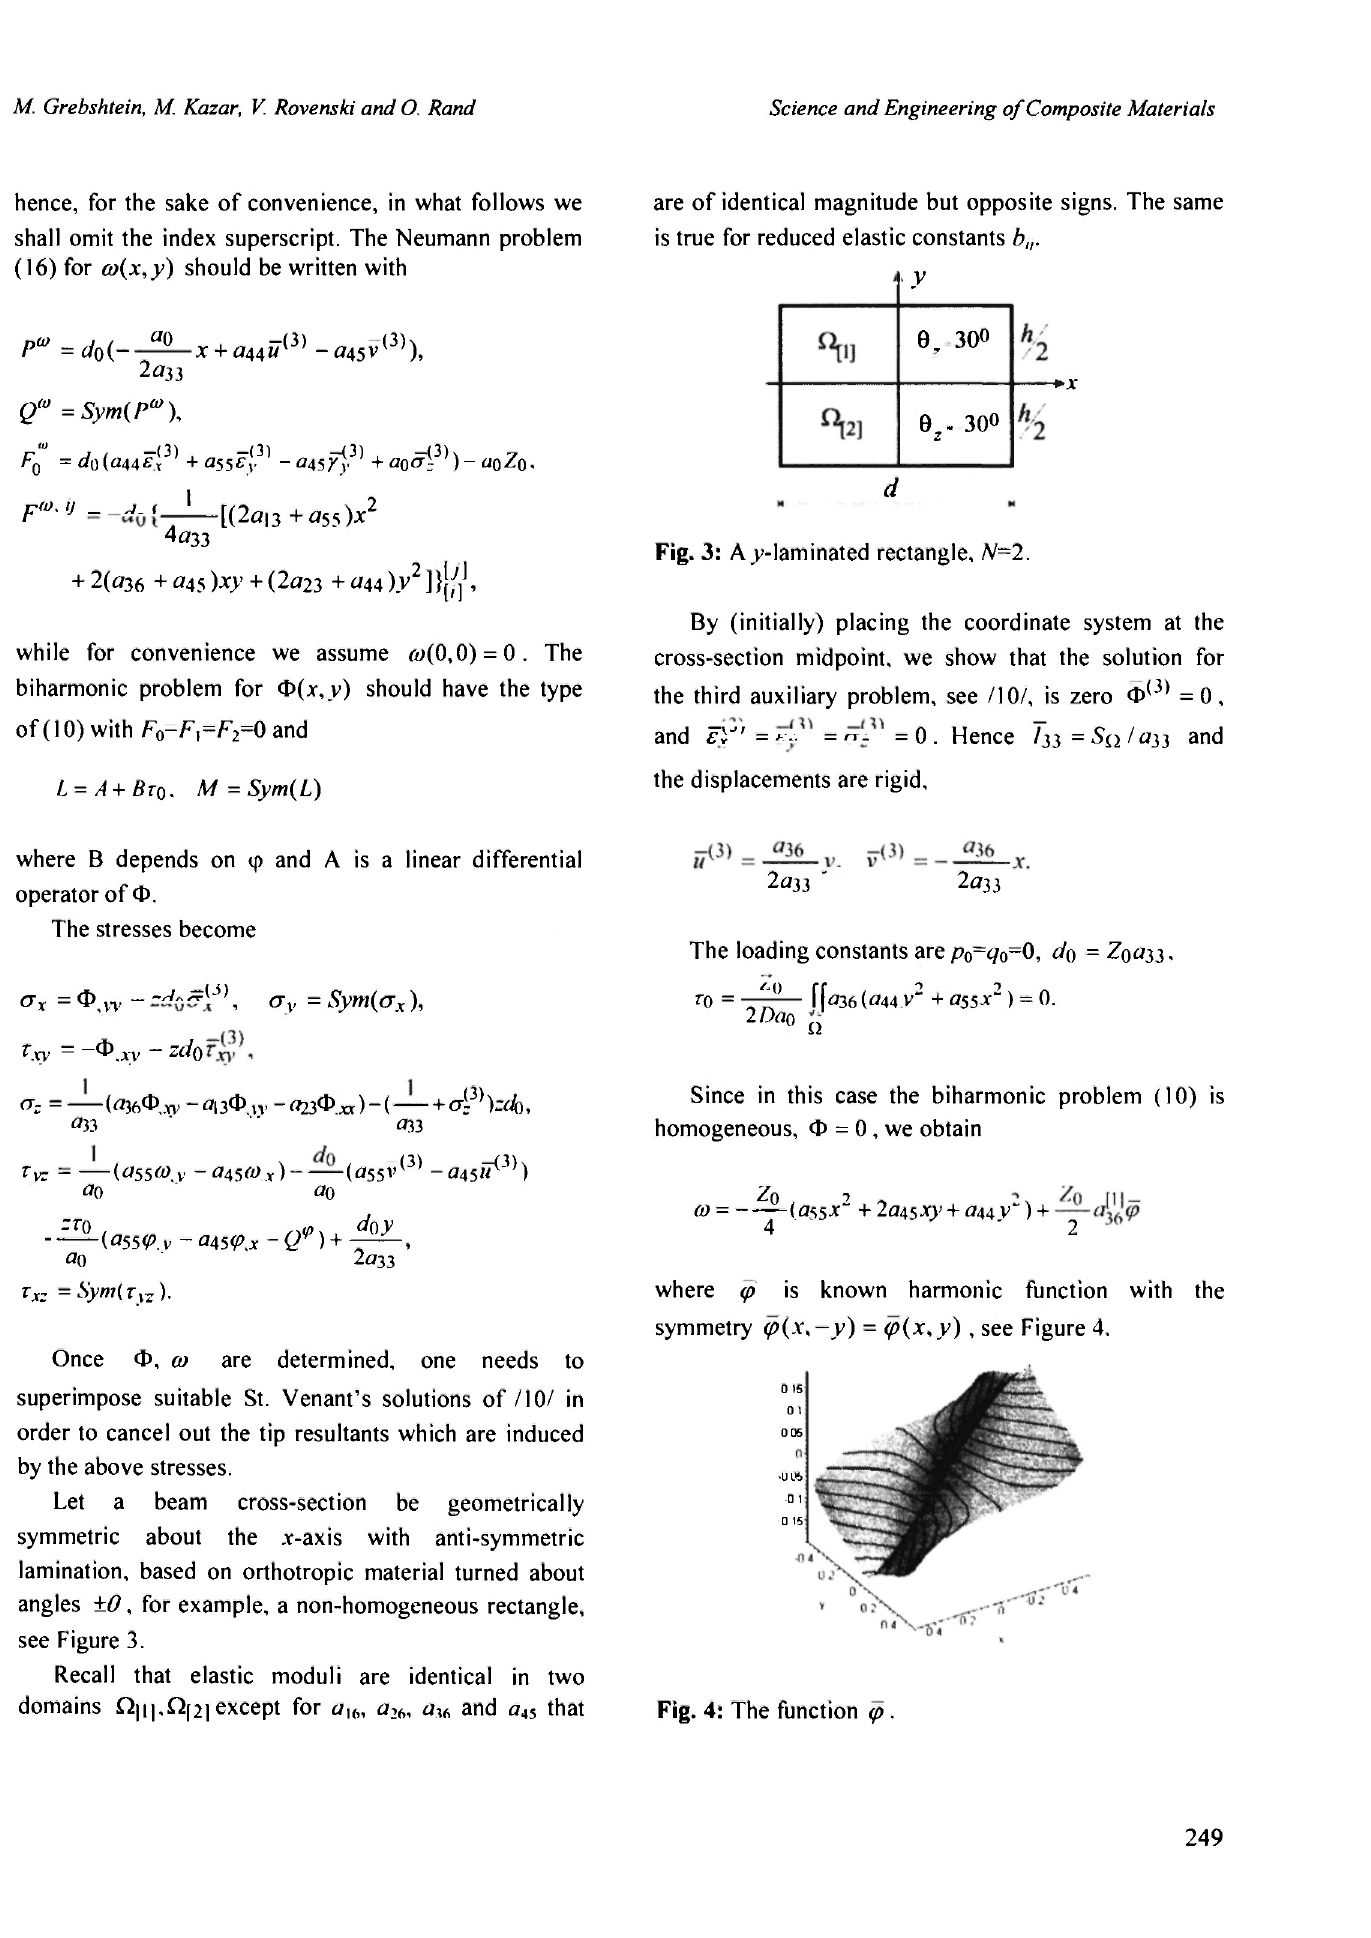
Fig. 4: The function φ